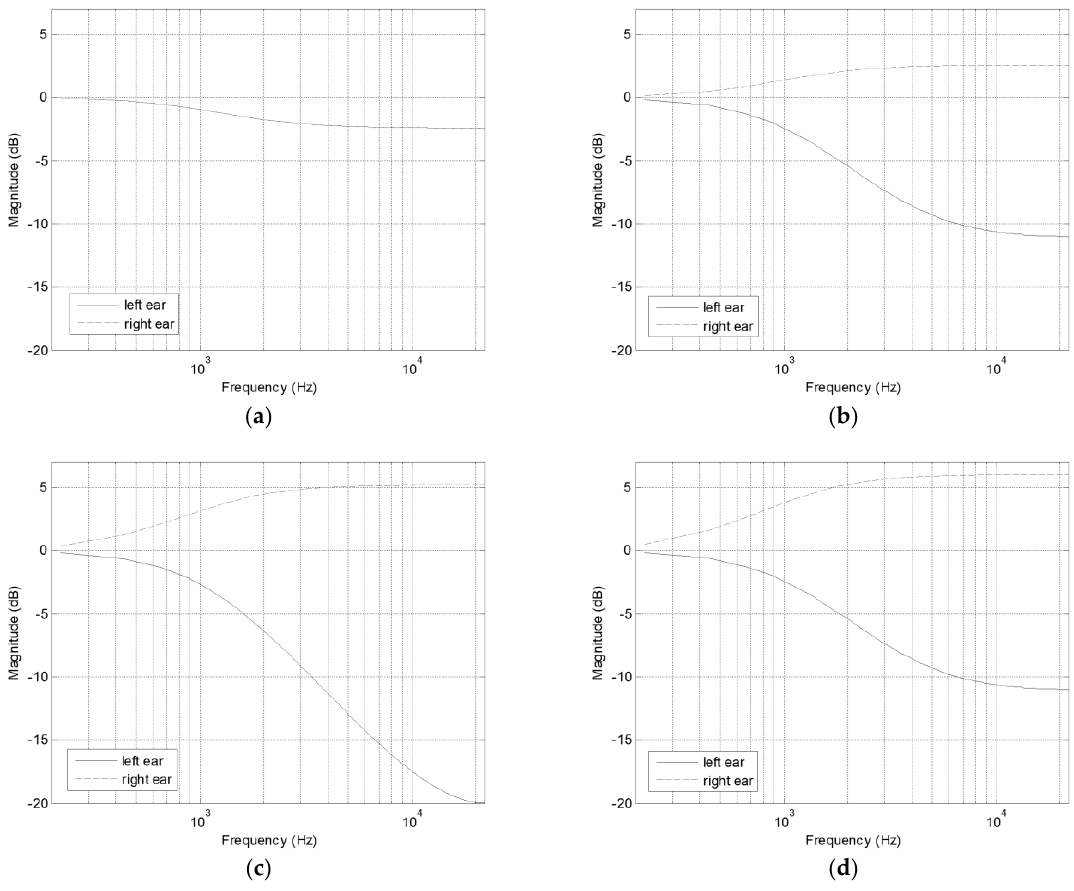
Figure 13. Geometry and spherical model with an angle θ of incidence for IID calculation. To obtain the head-shadow transfer function for a left ear, θ has to be replaced by θ − π . The magnitude frequency responses with θ changing from 0 to π are shown in Figure 14, 2 where we can find that the high-frequency magnitudes of the shadowed ear, the left ear in this example, are attenuated.